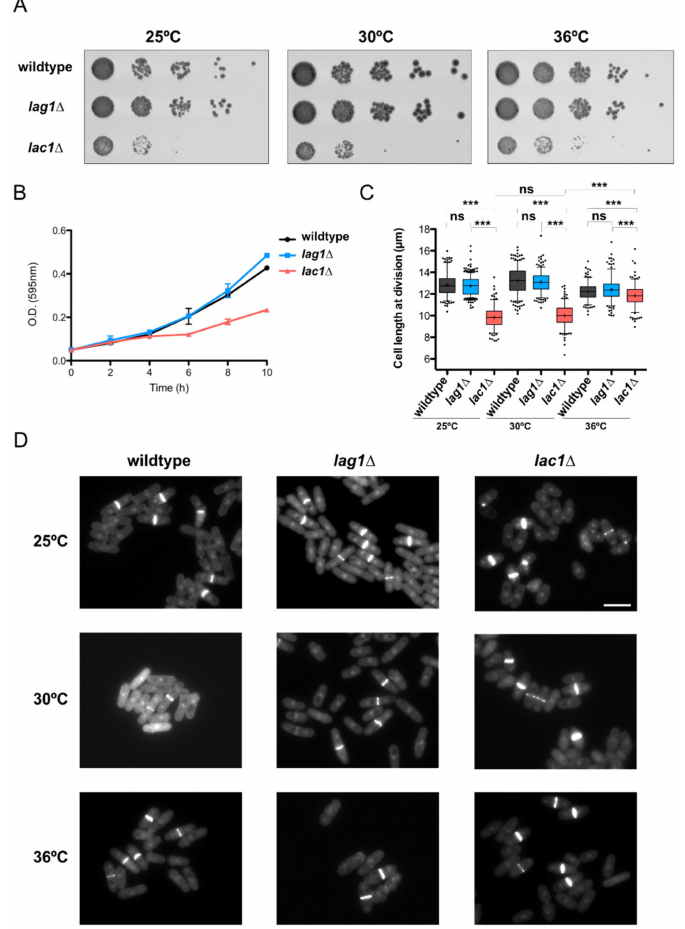
Figure 4. Ceramide synthase subunit Lac1 is implicated in control of cell growth and size. ( A ) A series of 10-fold dilutions of the indicated strains were grown at 25, 30 or 36 ◦ C for 2 to 3 days on YES media. ( B ) Absorbance at 595 nm of the indicated strains grown in YES media at 25 ◦ C. Error bar shows standard deviation from three different experiments. ( C ) Box-and-whisker plot showing cell length at division in wild-type, lag1 ∆ and lag1 ∆ strains at different temperatures. Boxes extend from the 25th to 75th percentile, while whiskers plot maximum and minimum values within the 5–95 percentiles. Points below and above whiskers show outside values. N > 250 cells for each condition; ns = not significant; p -value was determined by Student’s t -test. *** Denotes p < 0.0001. ( D ) DAPI–Calcofluor staining of cells grown in ( C ). Scale bar is 10 µ m for all the